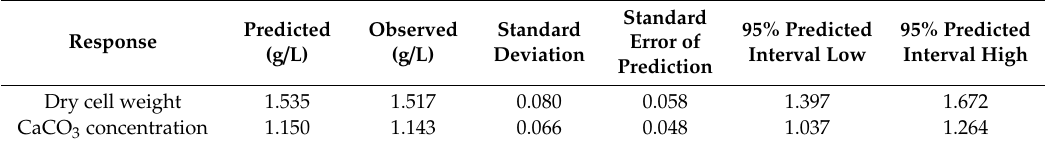
Table 7. Statistical analysis of validation